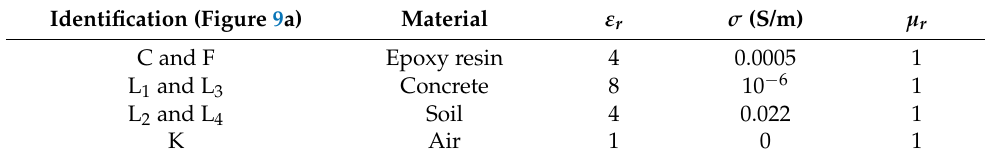
Table 1. Electromagnetic parameters of materials represented in FDTD